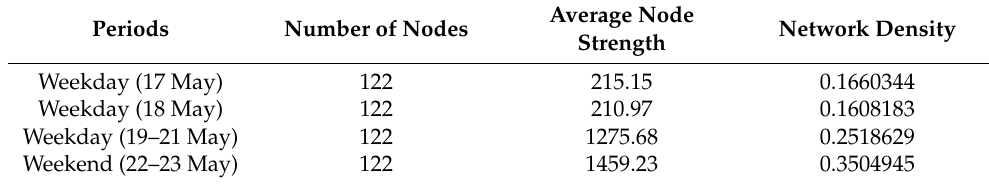
Table 5. Basic index statistics of the network. Periods Number of Nodes